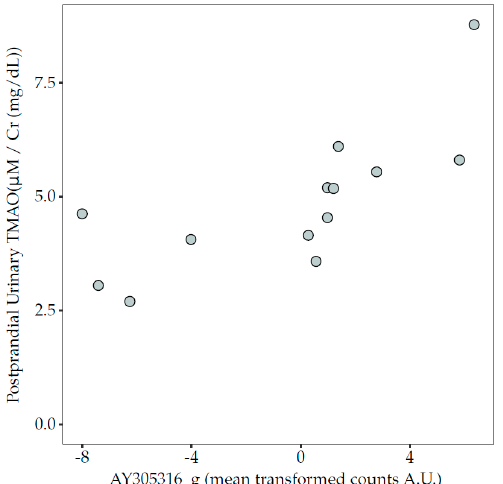
Figure 5. Association between the relative abundance of genus AY305316_g (centred, log-ratio transformed counts) and concentration of TMAO in 6 h pooled urine collected in the postprandial phase after the acidified milk test (Spearman’s correlation, rho = 0.84, p = 0.0008, FDR = 0.06). FDR, false discovery rate; TMAO, trimethylamine-N-oxide.